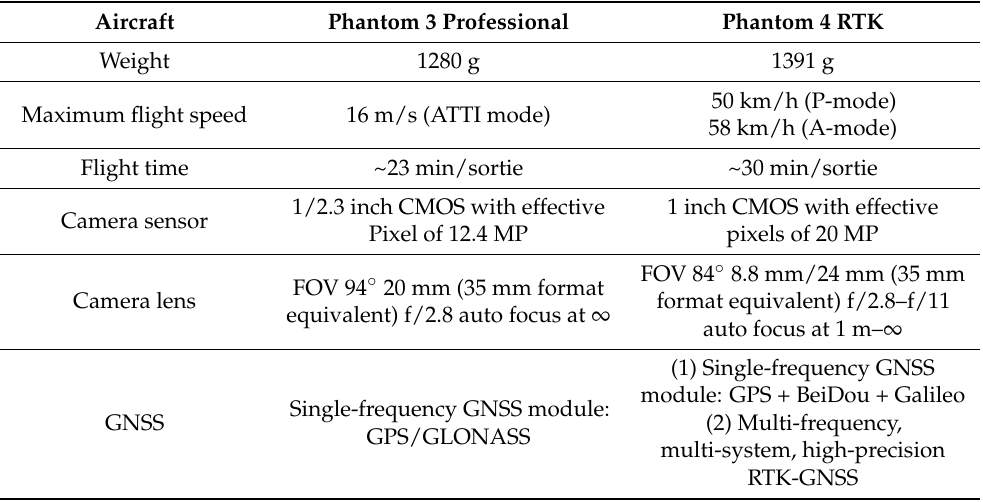
Figure 2. Photographs of the drones and ground control points (GCPs). ( A ) Phantom 3 Professional UAV; ( B ) Phantom 4 RTK UAV; ( C ) GCPs were measured with a Trimble RTK; and ( D ) inset shows a close-up of a GCP in the P3P UAV photograph from the May 2018 survey. Table 1. UAV specifications (from https://www.dji.com/cn, accessed on 5 February